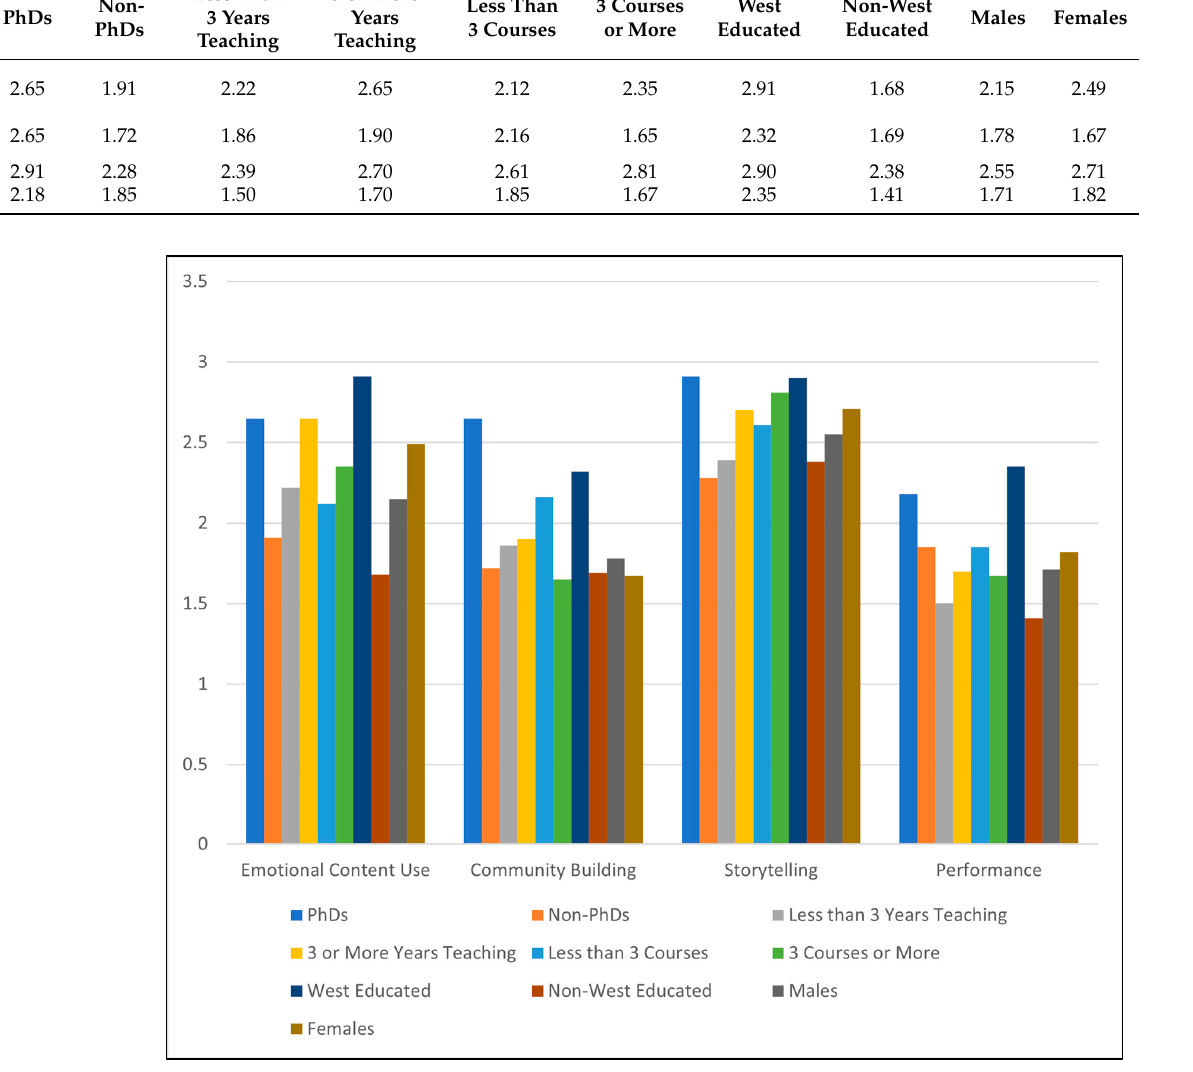
Figure 2. Grouped means of the constructs in Table 5.